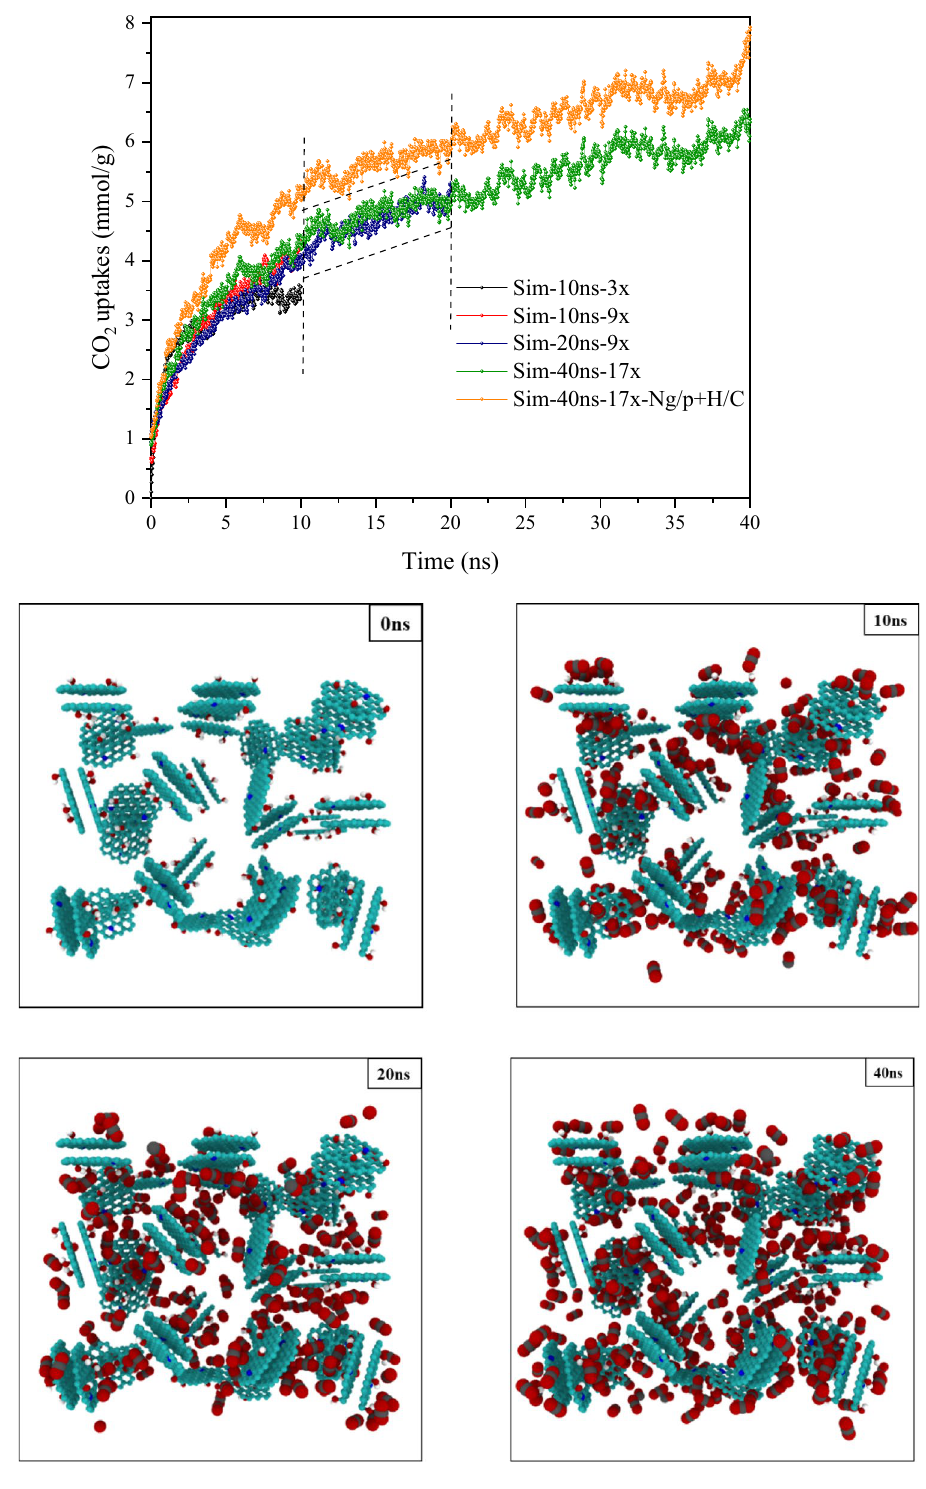
Figure 7. Comparison of the adsorptive capability (at 298 K under 10 bar) in various simulation boxes at 10–40 ns for initial structure and optimal